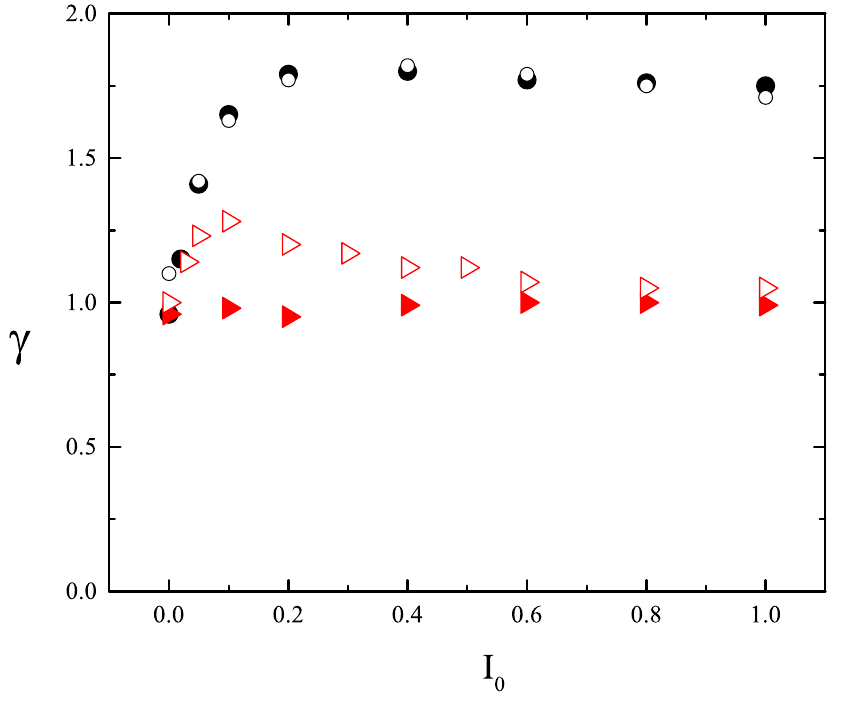
Figure 17. Plot of exponent γ ( I 0 ) . FP model: Θ = 0 ◦ , ∇ I = 0 (black circles) and ∇ I = 0.005 (empty circles). PI model: ∇ I = 0 (red triangles) and ∇ I = 0.005 (empty red triangles). T =